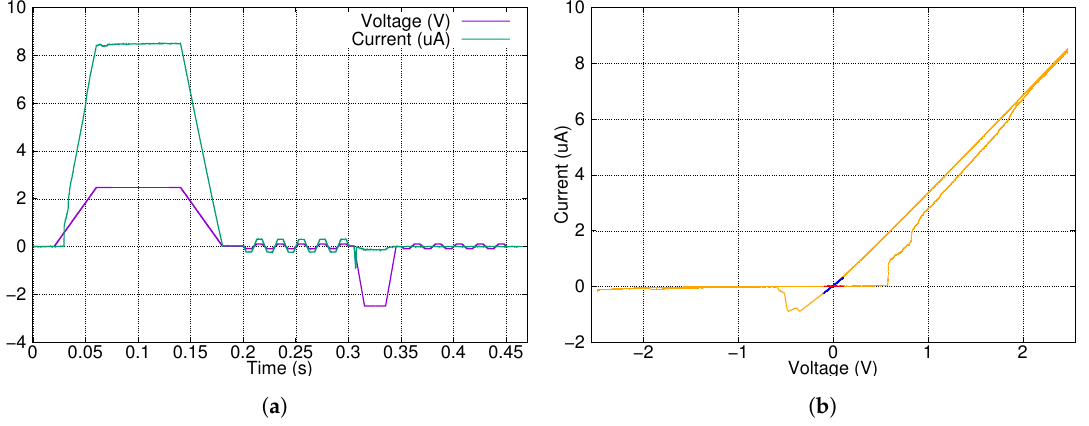
Figure 5. Write-read-erase-read cycle measurement on a single memristor device. ( a ) The input signal and output response in the time domain. ( b ) Phase portrait of the measurement. The read sequence after the write and erase pulses are colored as blue and red,